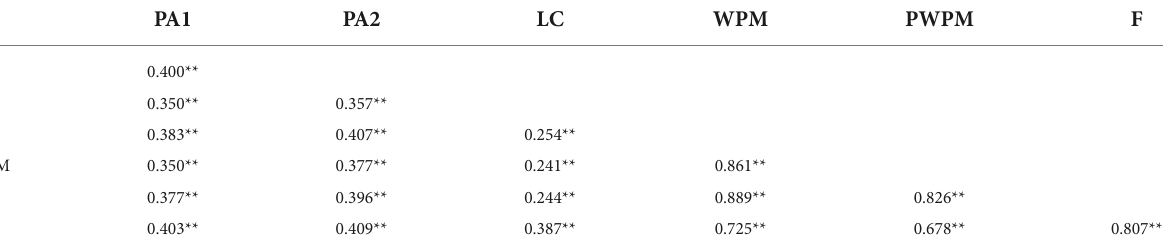
TABLE 2 Pearson’s correlation indices, fourth